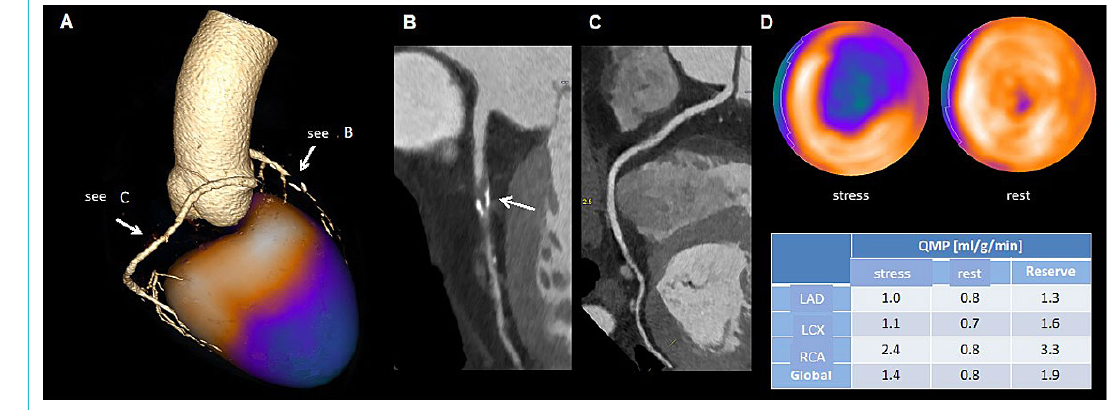
Figure 3: Example of hybrid imaging using coronary computed tomographic angiography anatomical and rubidium positron emission tomogra- phy perfusion information (a). In (b) and (c), the anatomic information is depicted, demonstrating a high grade left anterior descending artery (LAD) stenosis with non-calcified and calcified parts (b) and demonstrating the right coronary artery (RCA) (c). Figure 3d demonstrates the perfusion defect during stress (ischaemia), the normal perfusion at rest and the decreased flow rates, especially in the LAD